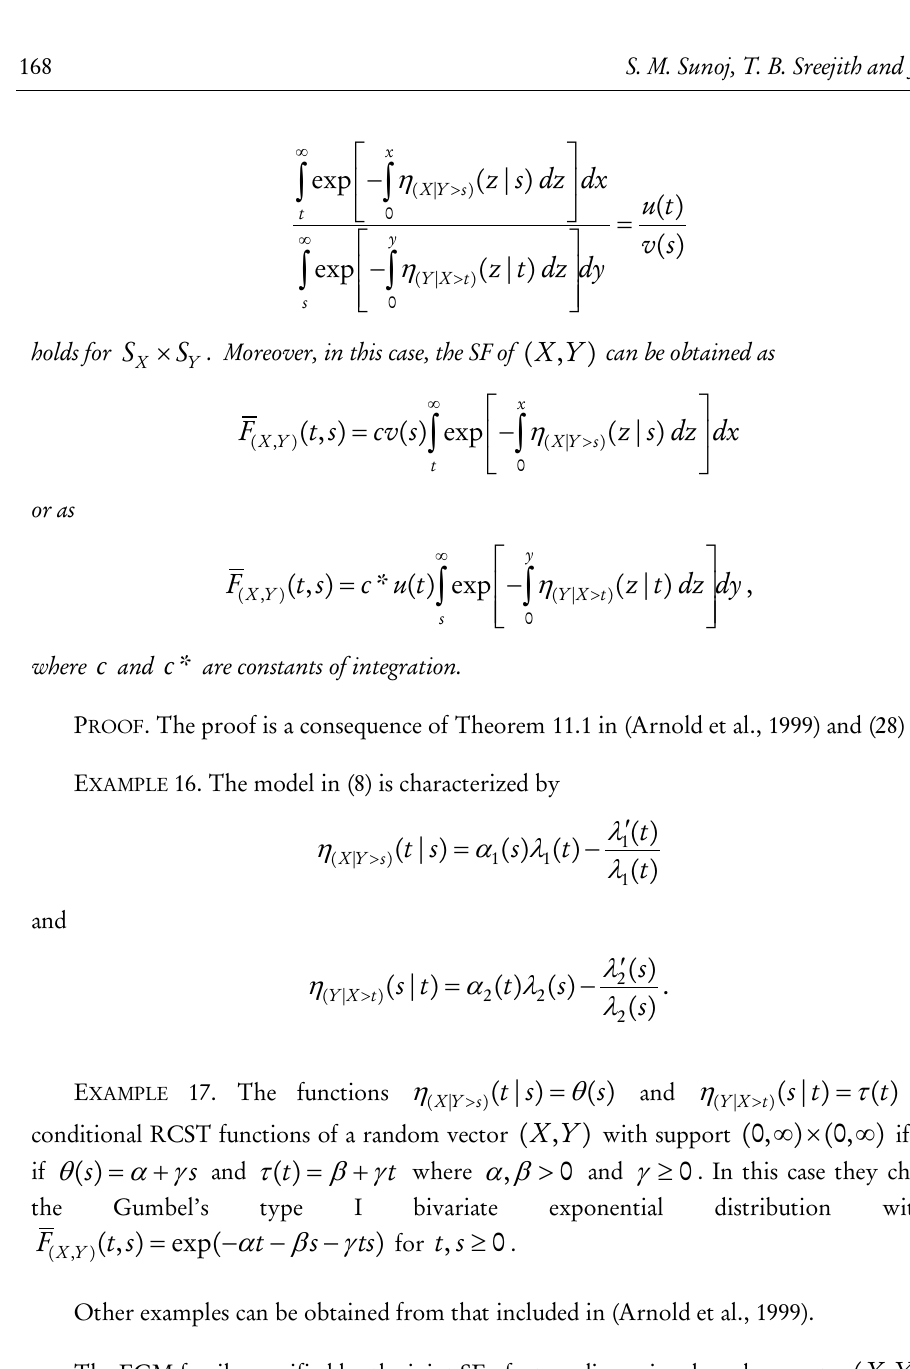
F t ( ) and F s ( ) X Y